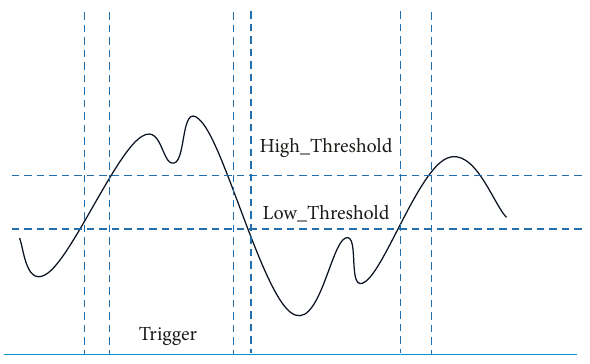
Figure 3: waveform of leakage current analog trigger signal. Table 1: Test results of indirect contact leakage fault.